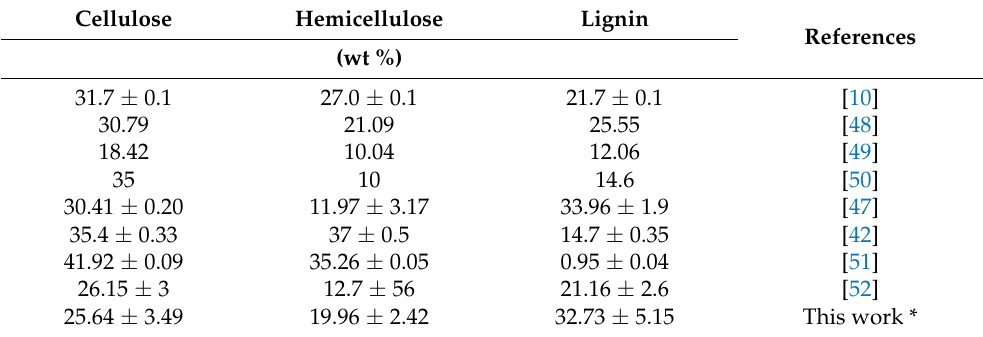
Table 2. Structural carbohydrates and lignin in cacao husk (CH) from cacao fruit samples of various origins and this work.